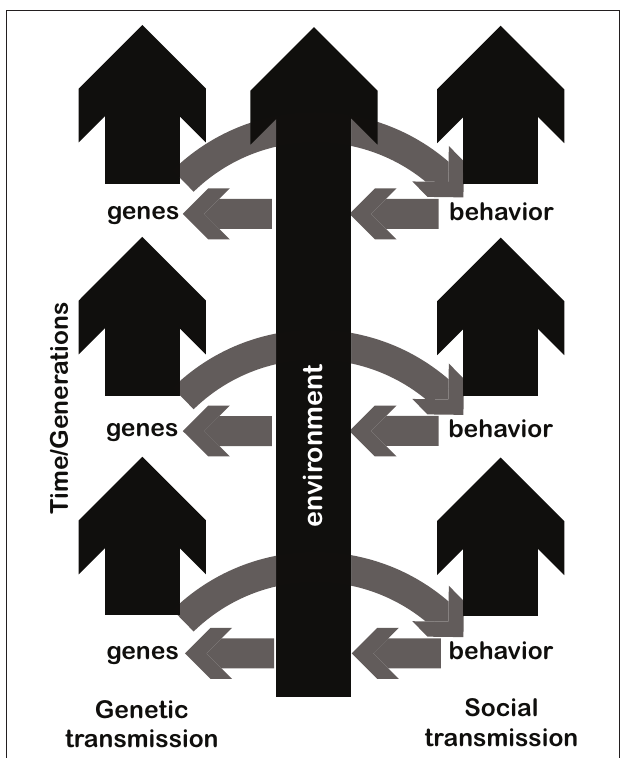
FIGURE 1 | The arrows depict the potential three-way interaction between genes, environment and musical behaviors. Figure inspired by Deacon (1998). Over time, both genes (left) and behaviors (right) change and are transmitted. The environment might change stochastically, or might be directionally altered by behaviors of the species populating it. For a given generation or time period, genes affect behavioral patterns. Behavioral patterns also adapt to, and modify, their environmental medium. In turn, behaviorally-driven changes in the environment might affect the fitness landscape of a species, influencing in turn which genes will be passed on to the next